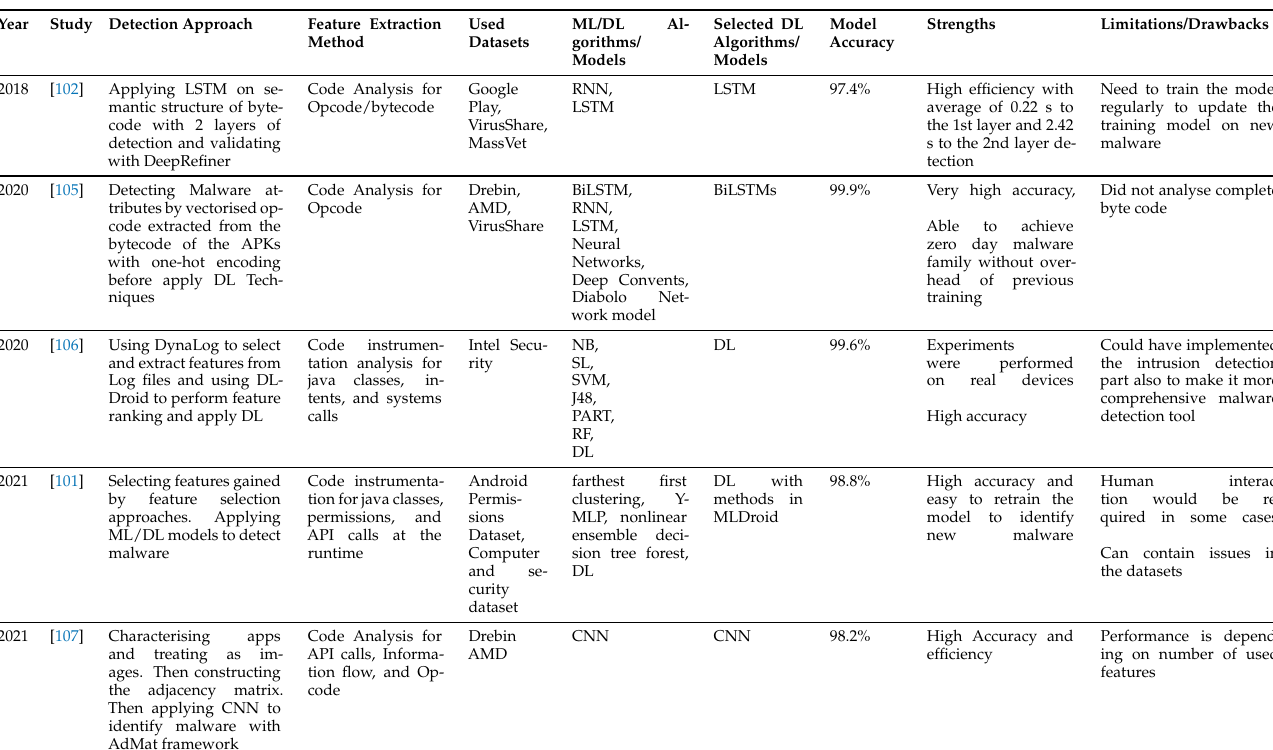
Table 9. Deep learning based malware detection approaches (model accuracy is above